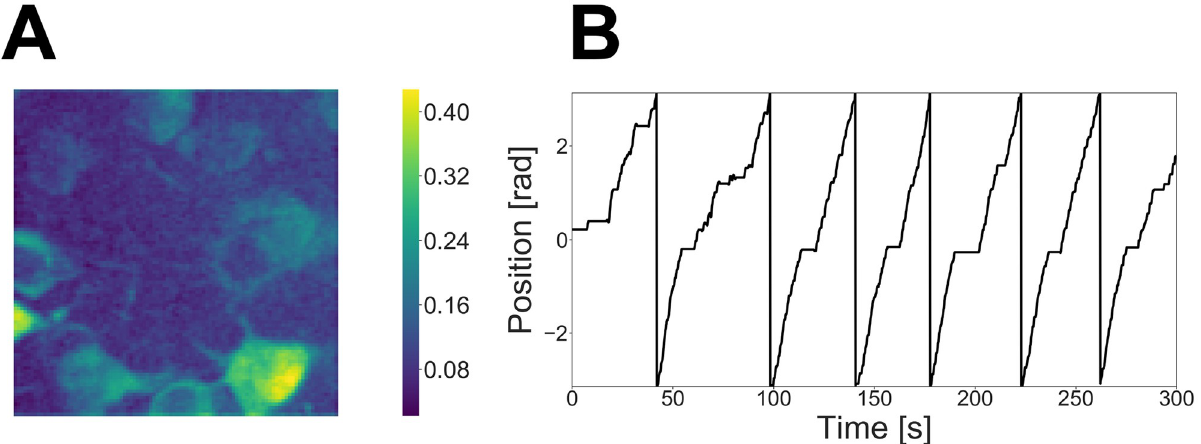
Fig 5. (A) Correlation image calculated from the calcium imaging movie. (B) Mouse trajectory throughout the